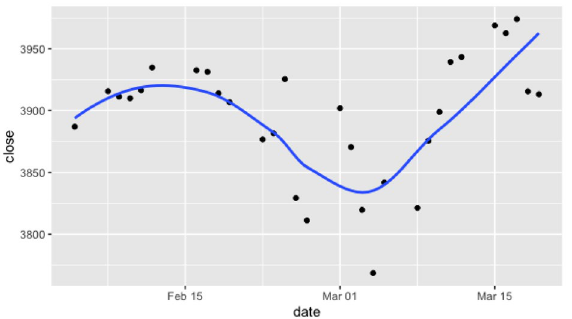
Figure 1. Daily Prices for S &P 500 from February 5, 2020 to March 19, 2020 with our simple polynomial regression line (shown in blue) indicates the trend. Observe that the price follows the general trend for a few unit of time, and thus a regression line can provide a useful